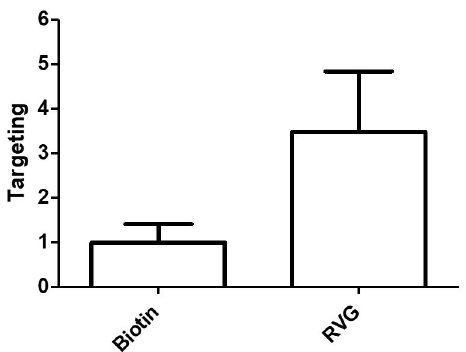
Figure 5. DiR delivery to the trigeminal nerve 2 h after intranasal administration of nanoparticles was much higher for RVG-NPS compared to ctr-NPs ( p = 0.05). Targeting is defined as the RVG-NP signal divided by the ctr-NP signal ( n = 5 per group).